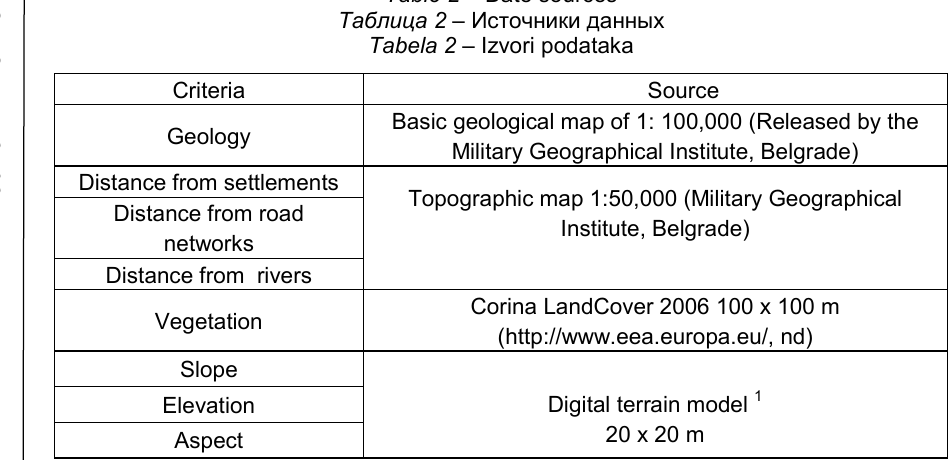
Таблица 2 – Источники данных Tabela 2 – Izvori